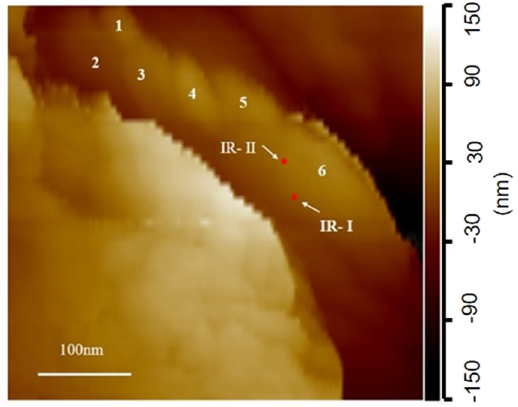
Figure 5: AFM image of a 400 nm × 400 nm surface area of a representative C – S – H sample along with distinct C – S – H gel particles numbered 1 – 6 and points of AFM - IR spectra collection denoted as IR - I and IR -